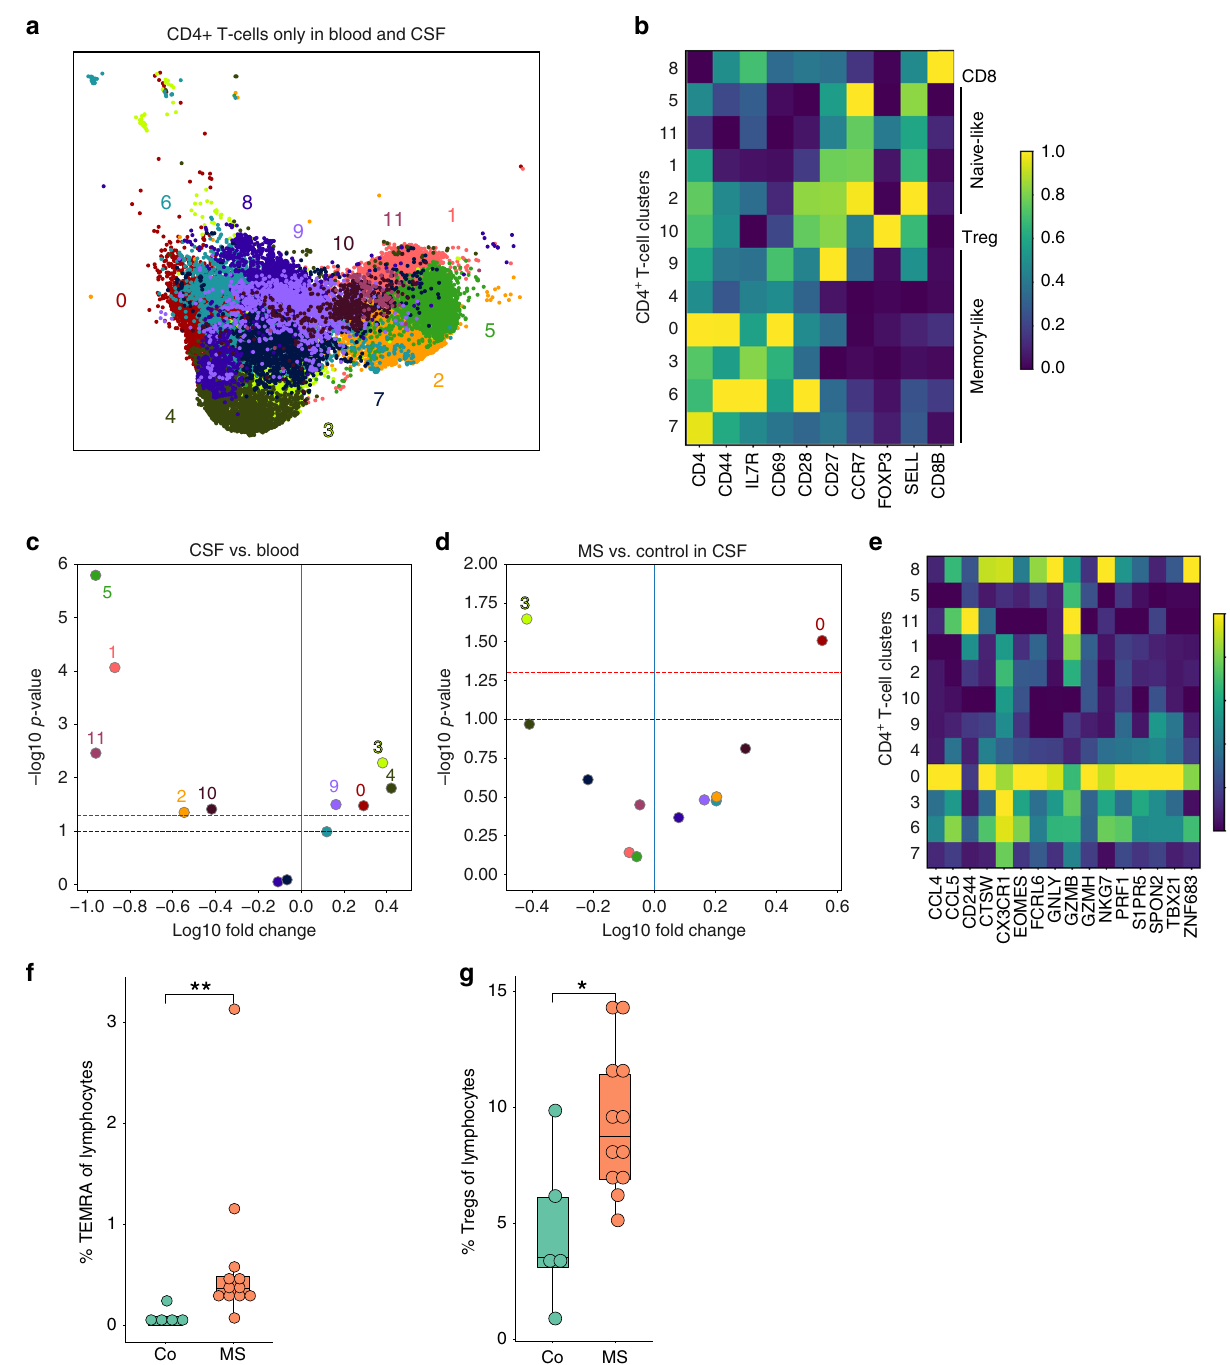
Fig. 3 Cytotoxic-like population of CD4 + T cells is induced in the CSF in MS. a UMAP plot showing sub-clustering of all CD4 + T cells combined from blood (13,933 cells) and CSF (11,172 cells). Sub-clusters are numbered 0 – 11. b Heatmap depicting per cluster average expression of selected T cell subset marker genes. Expression values were normalized per gene with 0 re fl ecting the lowest expression and 1 re fl ecting the highest expression. c Volcano plot showing differences of CD4 + T cell cluster abundance in CSF compared to blood as fold change (log10) against p value ( − log10) based on Student ’ s t -test. d Volcano plot showing differences of CD4 + T cell cluster abundance in MS compared to control within CSF based on Student ’ s t -test. e Heatmap showing average gene expression of selected cytotoxicity markers derived from 43 . Expression values were normalized per gene with 0 re fl ecting the lowest expression and 1 re fl ecting the highest expression. f The proportion of TEMRA cells (CD45RA + CD27 − ) among live lymphocytes in the CSF of control (co; n = 5) and MS ( n = 12) patients was quanti fi ed by fl ow cytometry. g The proportion of Treg cells (CD25 high CD127 low ) among live lymphocytes in the CSF of donors as in f was quanti fi ed by fl ow cytometry. Mann – Whitney U test, * p < 0.05, ** p < 0.01. The lower and upper edges of the box plots represent the lower and the upper quartile, respectively, the horizontal line inside the box indicates the median, and the whiskers extend to the most extreme values within the 1.5 interquartile range of the lower/upper quartile. Source data for ( b , e ) listing the differential expression values for all CD4 + T cells are provided in Supplementary Dataset 6. Source data for ( f , g ) listing the TEMRA and TREGS frequencies are provided in the Source Data fi